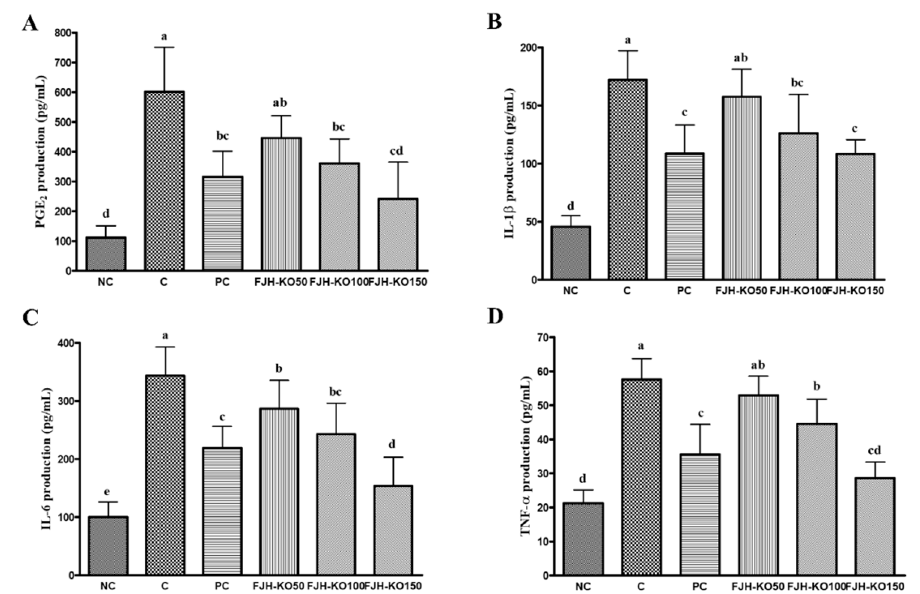
Figure 3 . Effect of krill oil on serum PGE 2 and pro-inflammatory cytokines levels in rat model with or